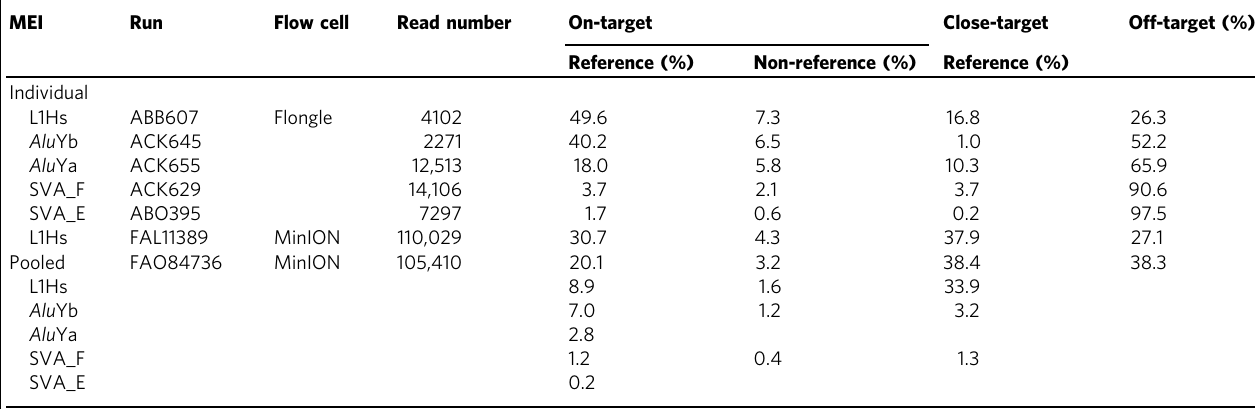
Table 1 Ef fi cient enrichment of mobile element signals in nanopore reads.